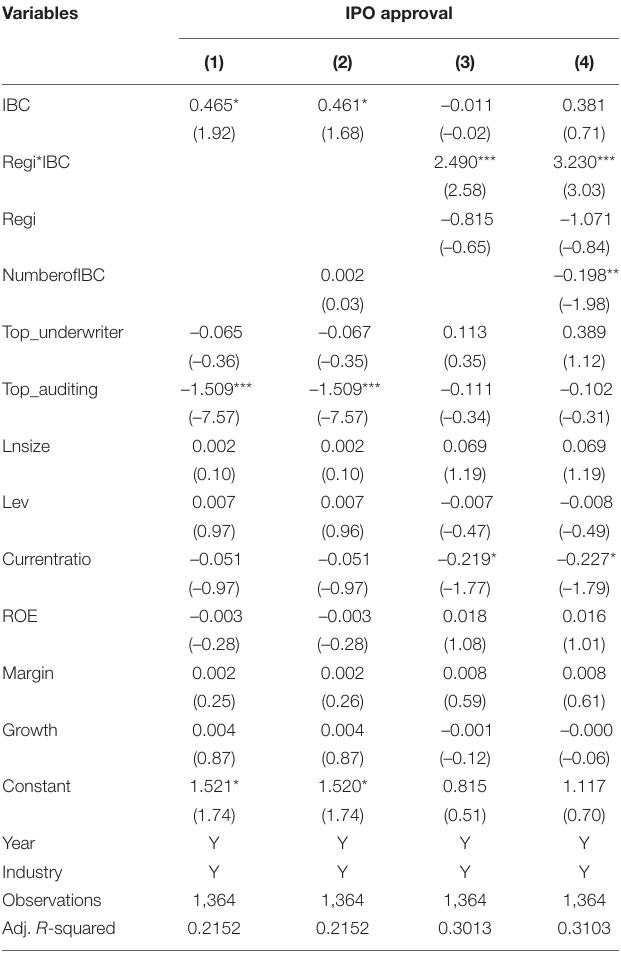
TABLE 13 | The impact of the registration system on the association between intermediate connection and IPO approval.